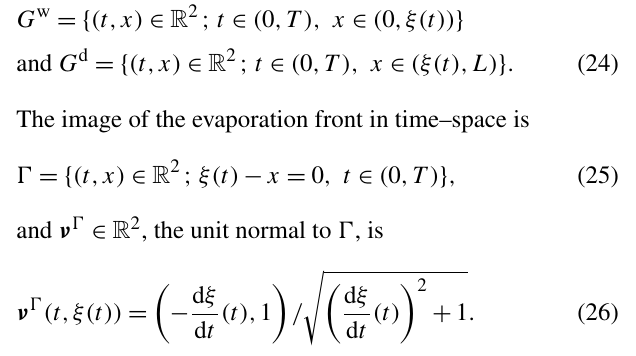
Figure 2. The x = 0 boundary condition – the pressure head at the boundary. The squares show the measured values, and the smooth function is their approximation h 0 (t) that was used in the solved